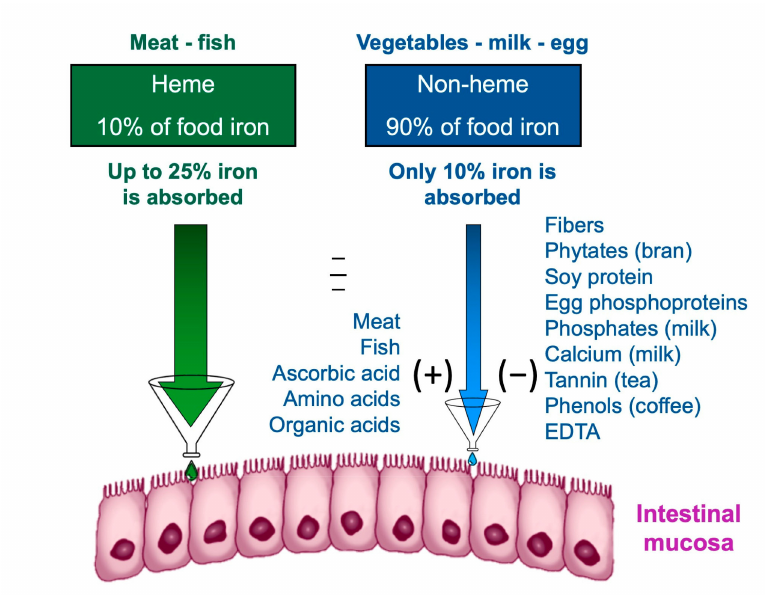
Figure 3. Intestinal iron absorption is influenced by diet